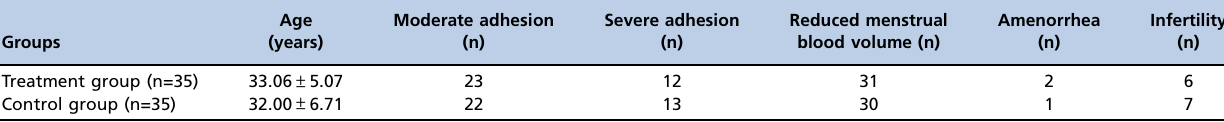
Table 1 - Baseline characteristics of the two groups of